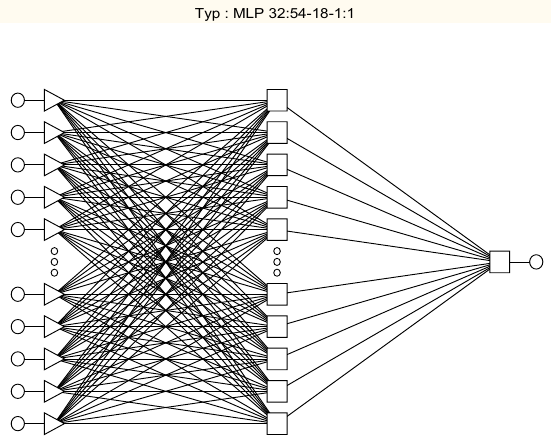
Figure 1. ANN results and model introduced and tested in the study.